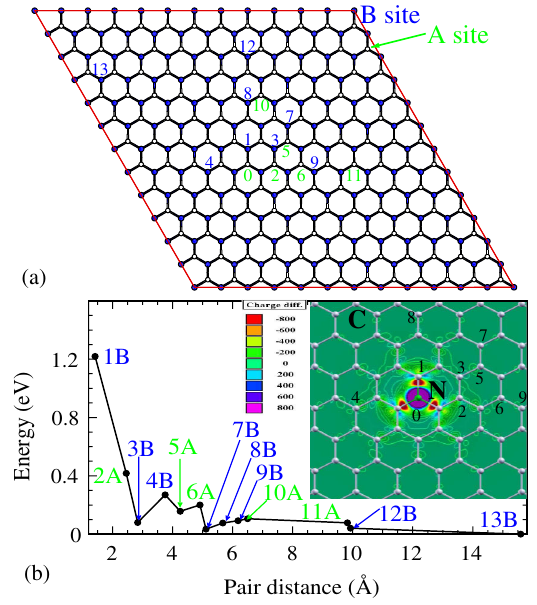
FIG. 1. (a) The 12 (cid:2) 12 graphene supercell. The small solid (blue) or empty circles belong to sublattice A or B, respectively. The numbers label the carbon-lattice sites for nitrogen substitu- tion. (b) The pair-interaction energy between nitrogen atoms as a function of the pair distance from the DFT total-energy calcu- lations for the relaxed structures. For each N-N pair, one of the nitrogen atoms is at the 0 site (one of the A sites) and the other nitrogen atom is labeled in (a). The inset in (b) shows the contour plot of the electron charge-density difference between the iso- lated N-doped graphene and undoped